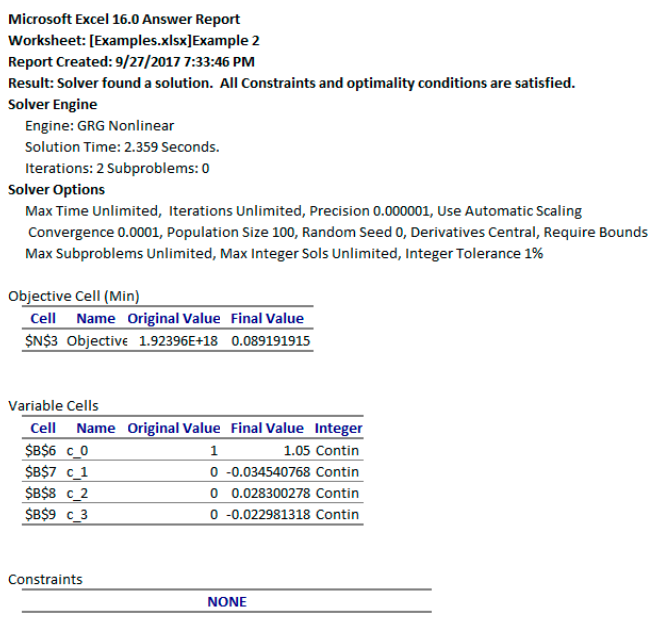
Figure 11. Answer Report generated by Excel’s Solver for optimal control problem (12)–(15) based on the initial guess values in Figure 8.